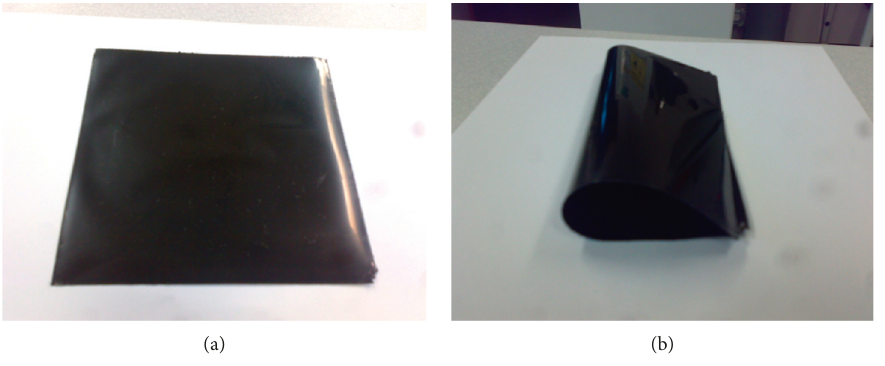
Figure 1: Images of the developed EC membrane.